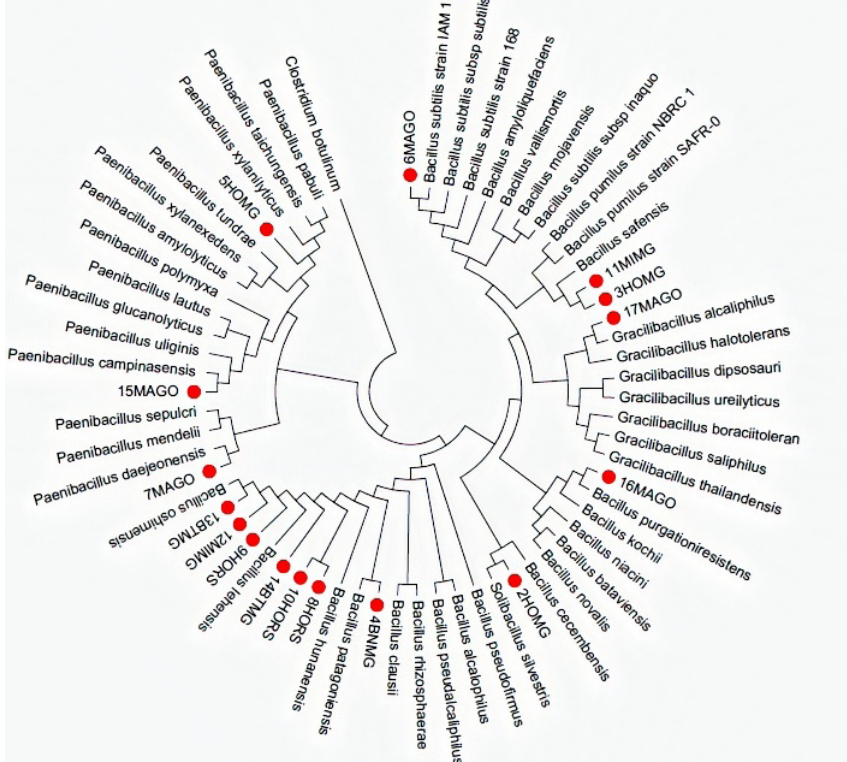
Figure 3 - Phylogenetic diagram constructed using the 16S rRNA molecular sequencing of the selected bacteria using the Neighbor-Joining with 1000